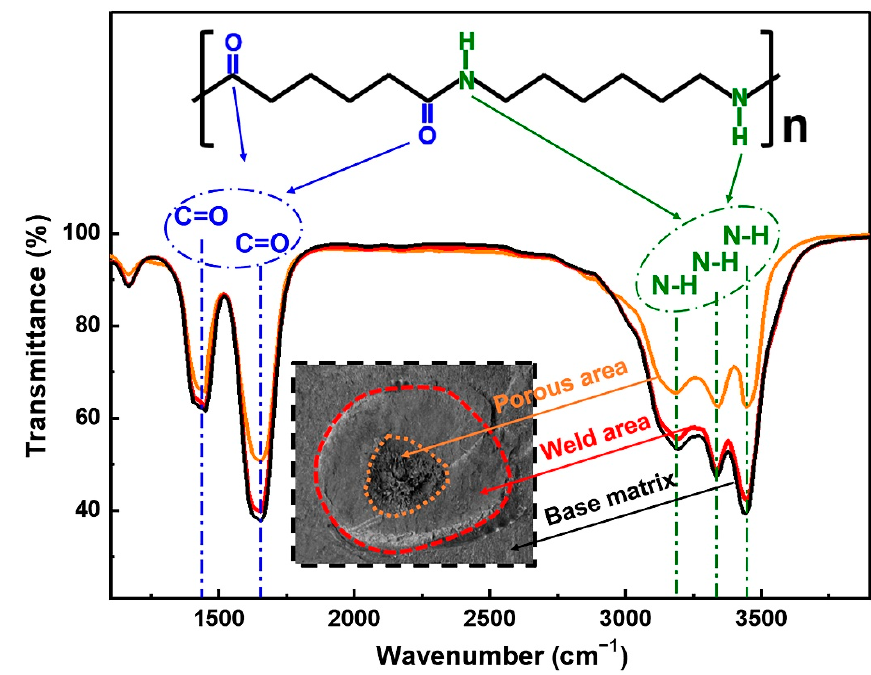
Figure 8. FTIR spectra of the matrix, weld area, and porous area.